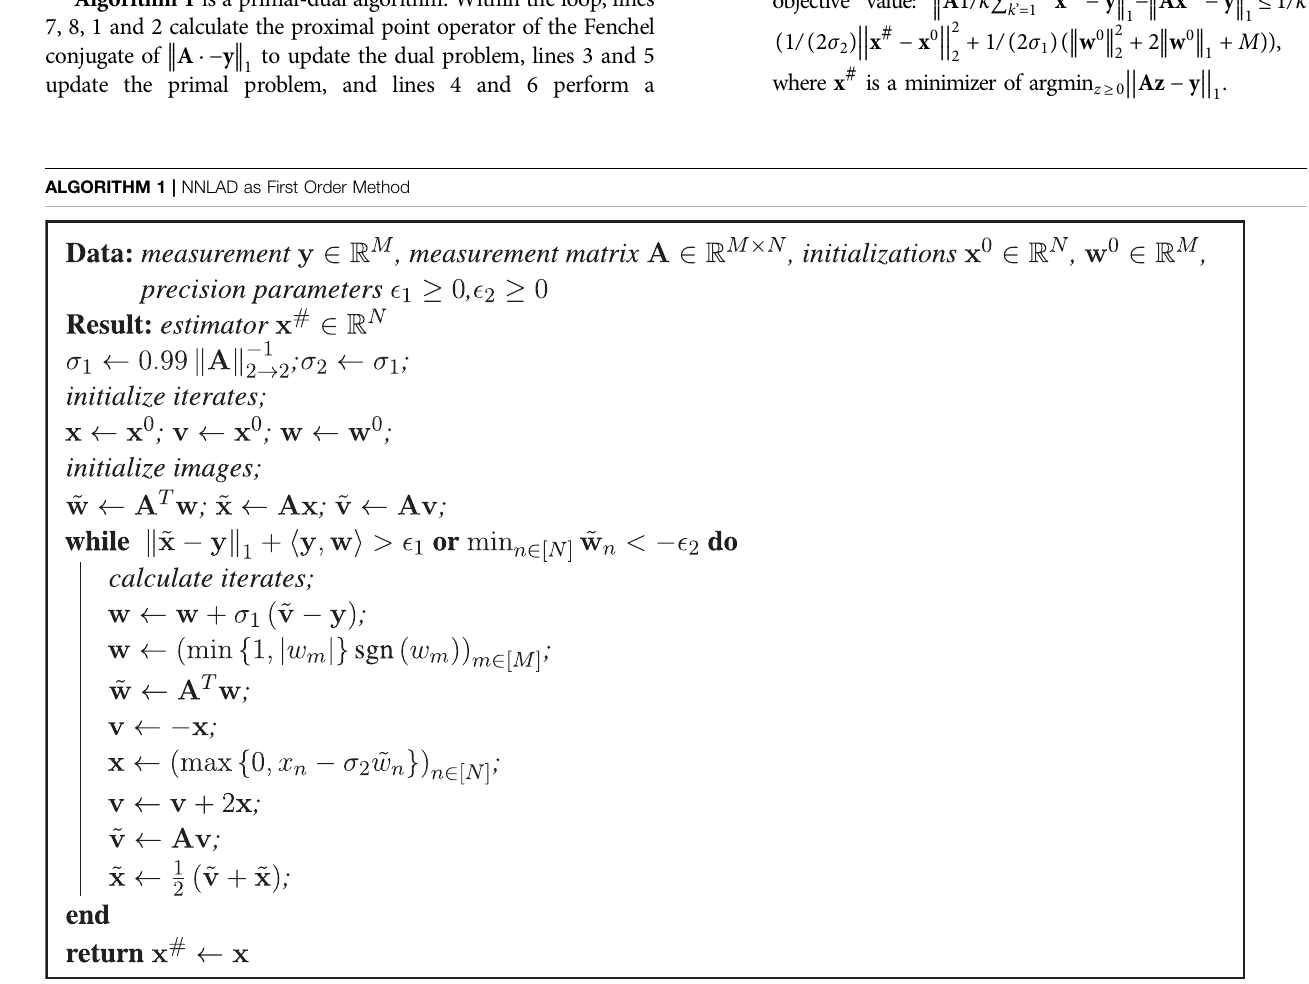
Algorithm 1 is a primal-dual algorithm. Within the loop, lines